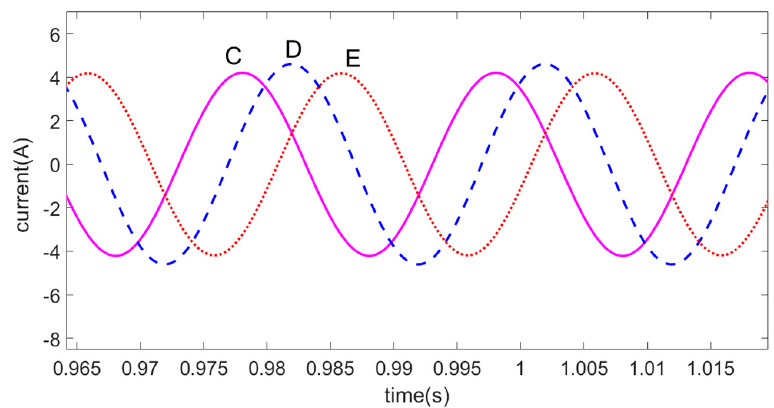
Figure 6. Schematic diagram of remaining three − phase currents when phase A and B are an open − circuit fault.